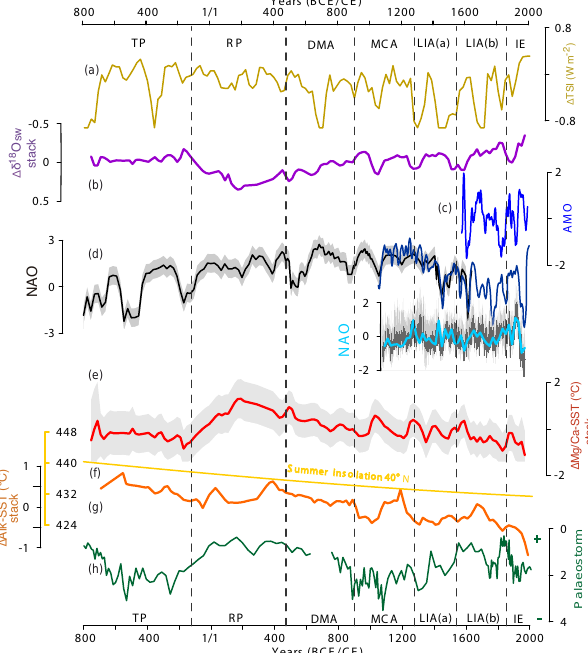
Figure 7. Temperature and isotope anomaly records from Minorca (this study) and data from other regions and with external forcings: (a) total solar irradiance (Steinhilber et al., 2009, 2012), (b) δ 18 O sw Minorca stacks, (c) Atlantic Multidecadal Oscillation (AMO; Gray et al., 2004), (d) North Atlantic Oscillation (NAO) reconstructions (Olsen et al., 2012; Trouet et al., 2009; and, for the last millennium, Ortega et al., 2015), (e) Mg / Ca–SST anomaly Minorca stack, (f) summer insolation at 40 ◦ N (Laskar et al., 2004), (g) alkenone– SST anomaly Minorca stack, and (h) palaeostorm activity in the Gulf of Lion (Sabatier et al.,